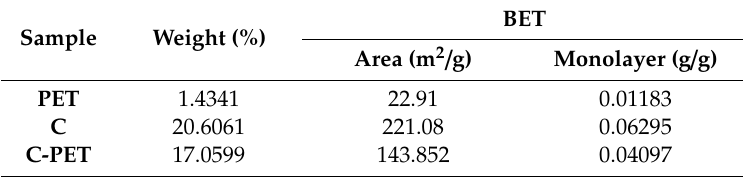
Table 1. Parameters evaluated using the kinetic model.